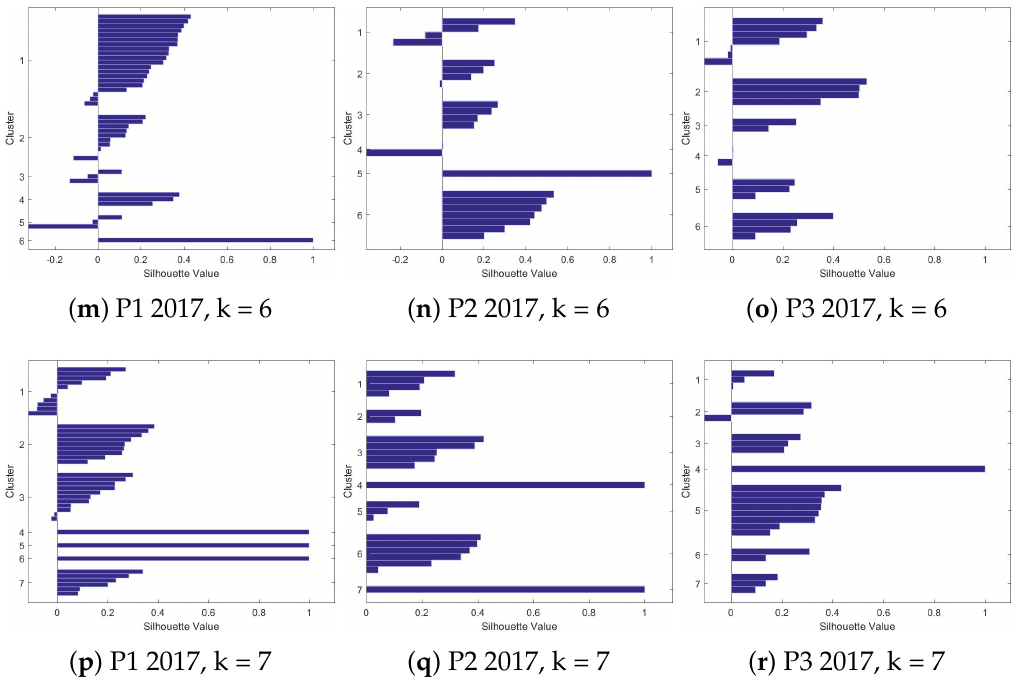
Sensors 2019 , xx , 5 Figure 5. Silhouettes charts for three different times in 2017. Figure 5. Silhouettes’ charts for three different times in 2017.